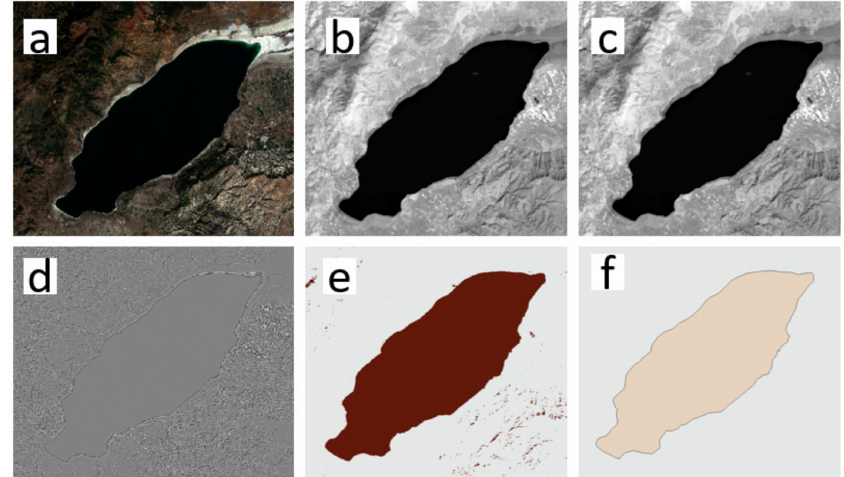
Figure 3. Results of Burdur Lake mapping of each processing stage. ( a ) the original Landsat image, ( b ) the NDWI map of Burdur Lake, ( c ) the smoothed NDWI image using a low-pass filter, ( d ) the edge-enhanced NDWI image using high-pass filter, ( e ) the binary map of water and non-water areas, ( f ) final extracted vector polygon of the Burdur